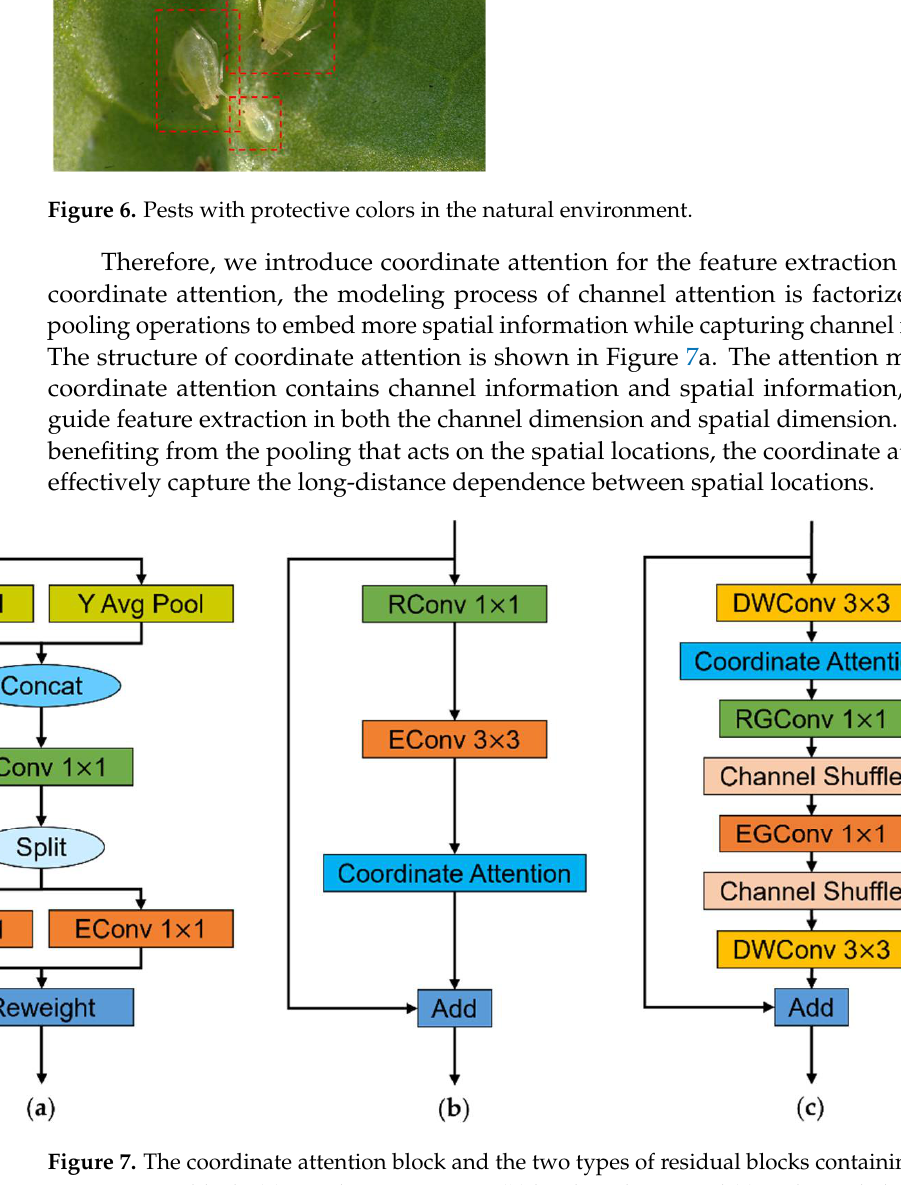
Figure 7. The coordinate attention block and the two types of residual blocks containing the coordi- nate attention block: ( a ) coordinate attention; ( b ) bottleneck-CA; and ( c ) LightSandGlass-CA.